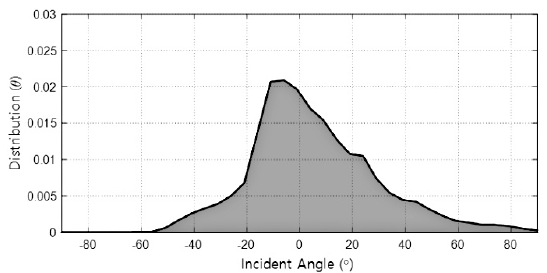
Figure 11. Distribution of the mean wave direction collected by an AWAC meter to the south of Jeongdongjin Beach.